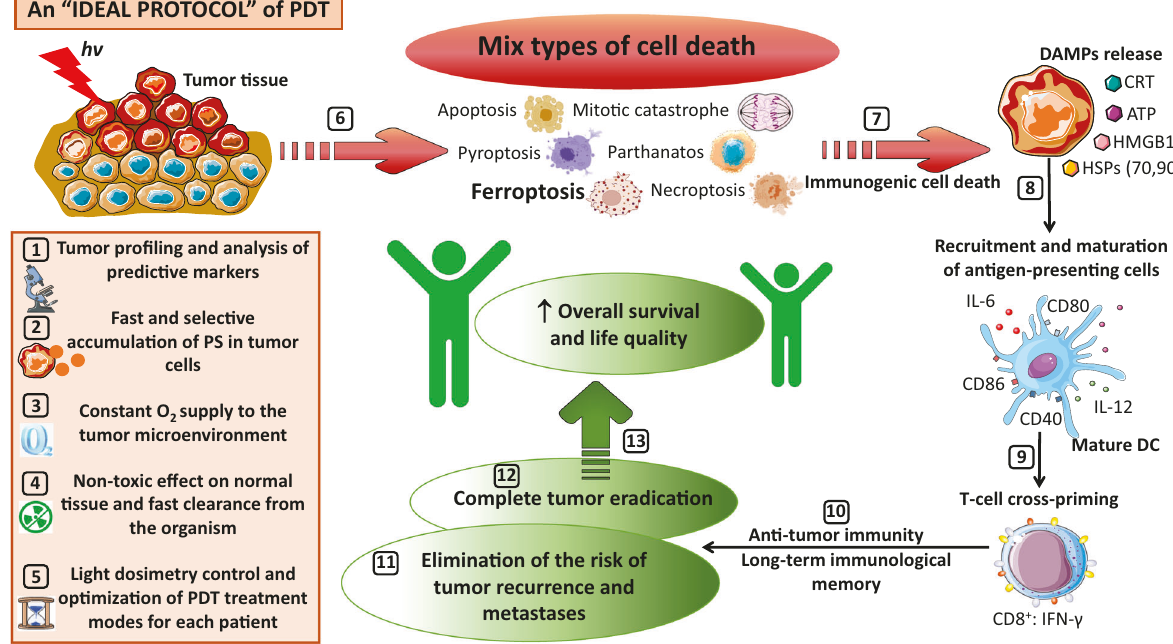
Fig. 3 An “ ideal ” protocol for PDT. An ideal protocol for PDT should comply with the following requirements. [1] Tumor pro fi ling and analysis of predictive markers for evaluation of the degree of tumor sensitivity to PDT. [2] The PS should have a constant chemical composition and photochemical characteristics that enable it to rapidly and selectively accumulate in tumor cells and to gain a strong cytotoxic effect during its photoinduction. [3] The approach should provide at least a suf fi cient oxygen supply to the tumor microenvironment for successful generation of photodynamic reactions. [4] The concentration of the PS and the irradiation dose should be tailored to the tumor ’ s origin and have minimal toxic side effects on normal tissue, even in the absence of photoinduction. [5] The PDT protocol should include a light dosimetry control procedure for timely optimization of PDT treatment modes for each patient. [6] Cancer cells exposed to PDT can proceed through several cell death pathways with either immunogenic or non-immunogenic properties that determine the therapeutic outcome of PDT according to the different scenarios. In an ideal protocol, the PS and treatment modes should lead to the simultaneous induction of several regulated forms of immunogenic cell death. We suggest that PDT-induced ferroptosis could be combined with other cell death modalities to boost PDT ef fi